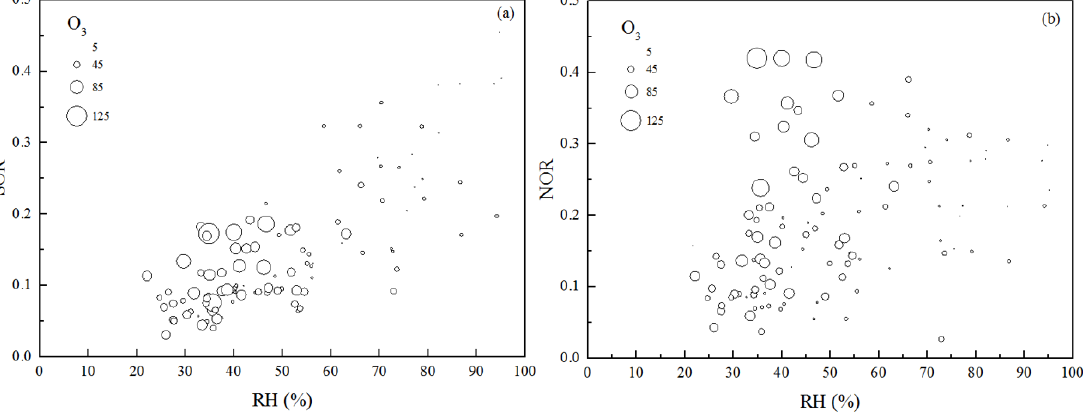
Figure 8. Relationships between RH and sulfate oxidation rate (SOR) ( a ) and nitrate oxidation rate (NOR) ( b ). Size-coded by O 3 concentration in PM 2.5 , where larger circles indicate higher O 3 concentrations.